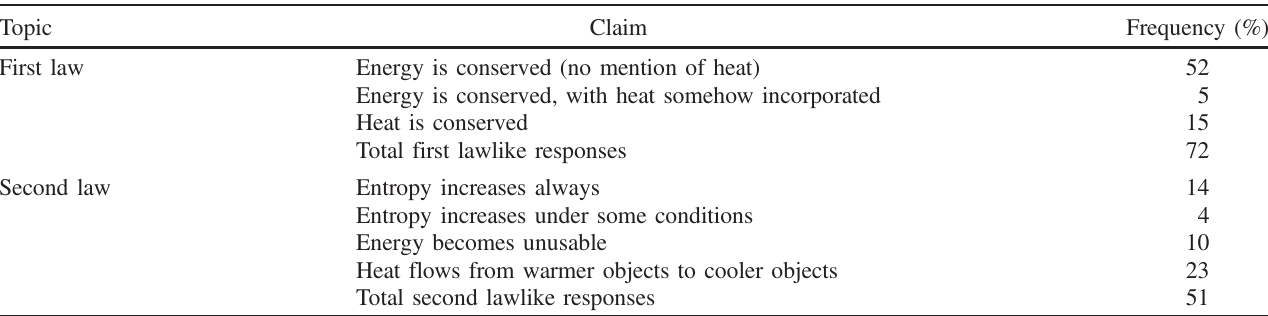
TABLE II. Responses of introductory physics students in an algebra-based course about the laws of thermodynamics based upon what they had learned in previous courses before instruction in these laws in that physics course. The percentages are determined by taking into account only the students who attempted to answer the bonus